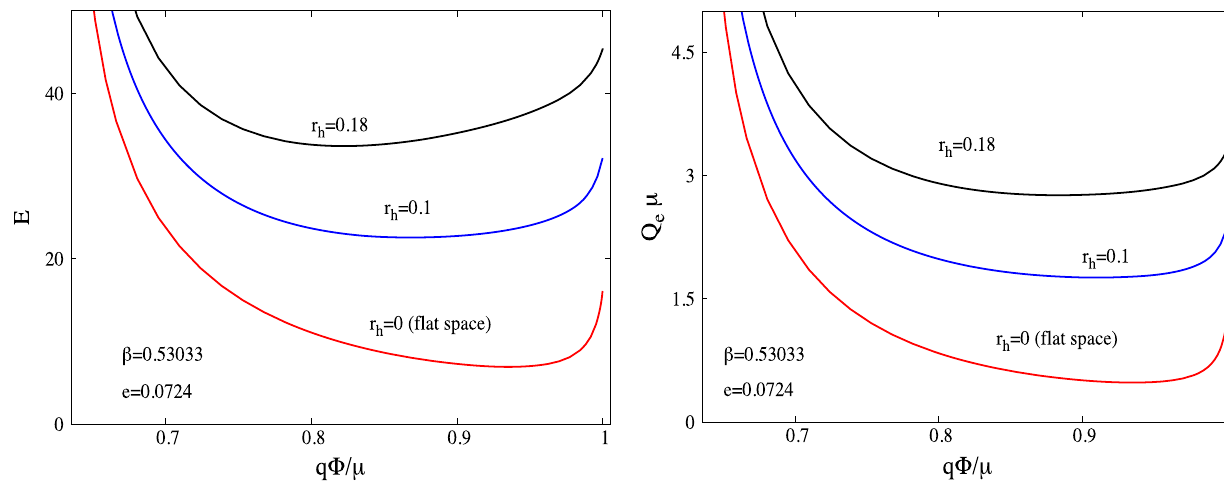
Fig. 1 Gauged Q-clouds on fixed Schwarzschild BH backgrounds. Mass-energy (left panel) and electric charge (right panel) v s . the chemical potential. r h is the event horizon radius; r h = 0 the Minkowski spacetime limit. All quantities are given in units set by μ